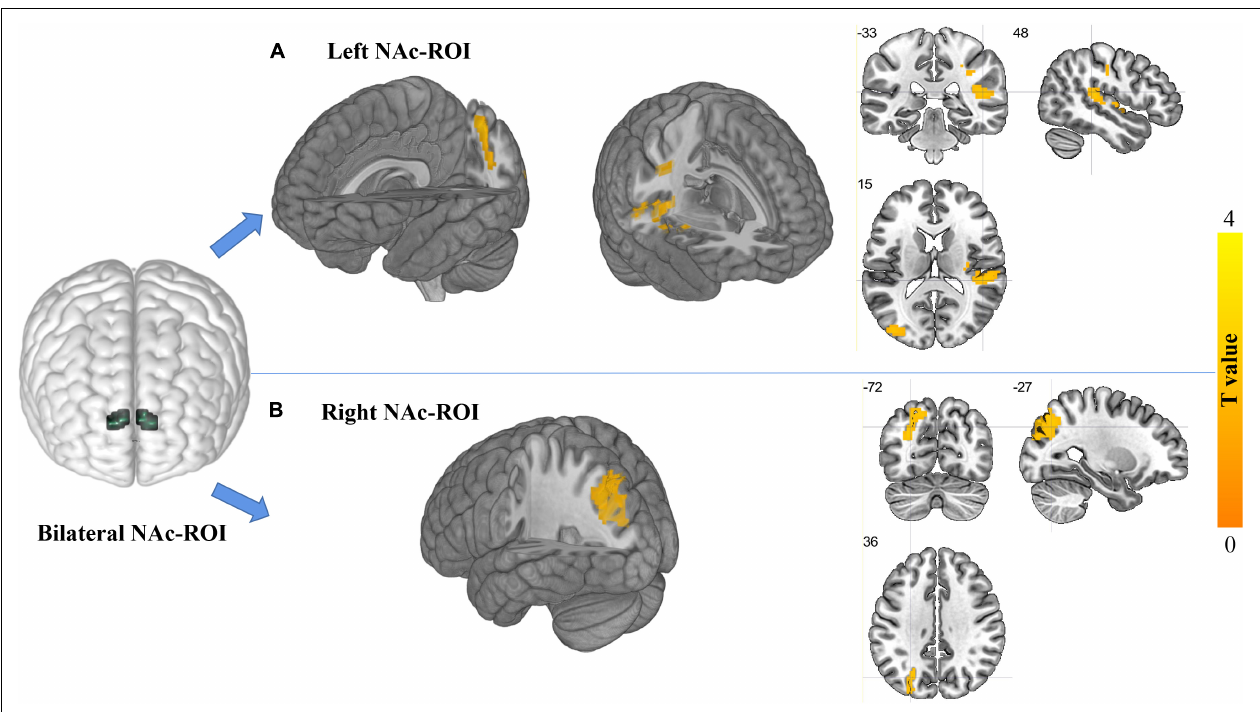
FIGURE 2 | Regions showing differences in FC with the NAc ROIs between groups (GRF corrected, voxel level, p < 0.005; cluster level, p < 0.05; minimum cluster size of 50 voxels). The locations of bilateral NAc ROIs in the brain are shown in the left part of the figure. (A) Regions showing increased FC with the left NAc ROI in the EOS group relative to the HCs. The cluster located in the crosshair corresponds to the right superior temporal gyrus, and another cluster without the crosshair corresponds to the left superior parietal gyrus. (B) Regions showing increased FC with the right NAc ROI in EOS relative to the HCs. The cluster located in the crosshair corresponds to the left middle occipital gyrus.